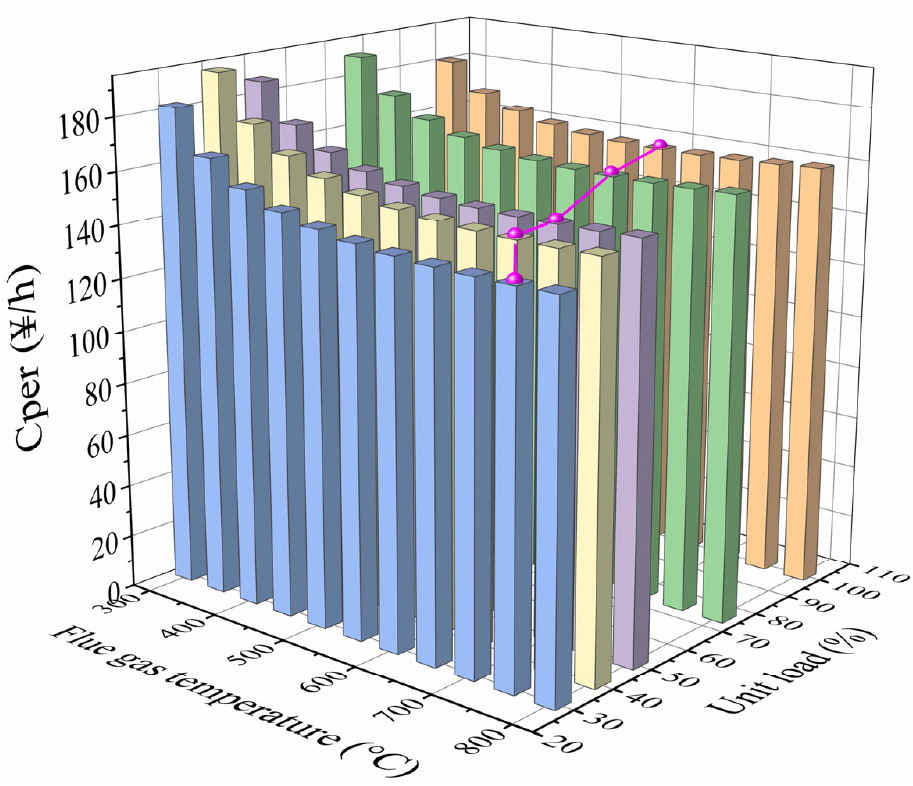
Figure 5. The C per value under operating conditions with different unit loads. Figure 5. The C value under operating conditions with different unit loads. (cid:3043)(cid:3032)(cid:3045)